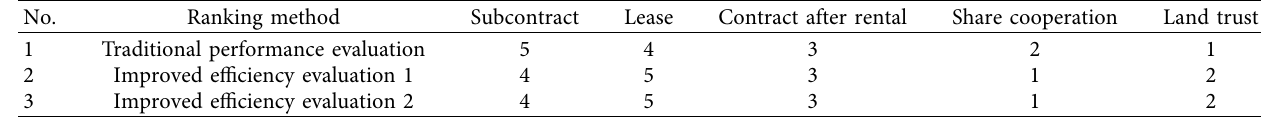
Table 8: Efficiency analysis ranking list of the rural land circulation mode performance